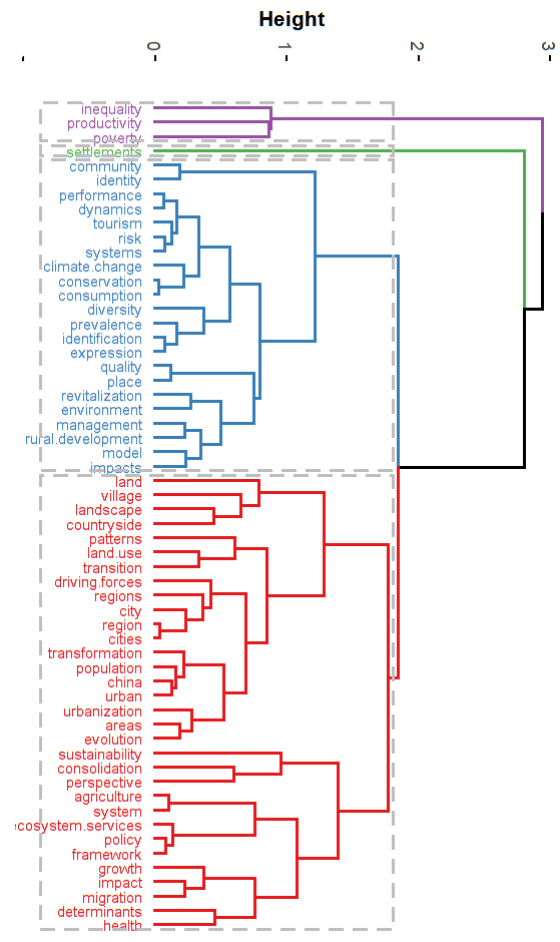
Figure 9. Cluster analysis of rural revitalization.